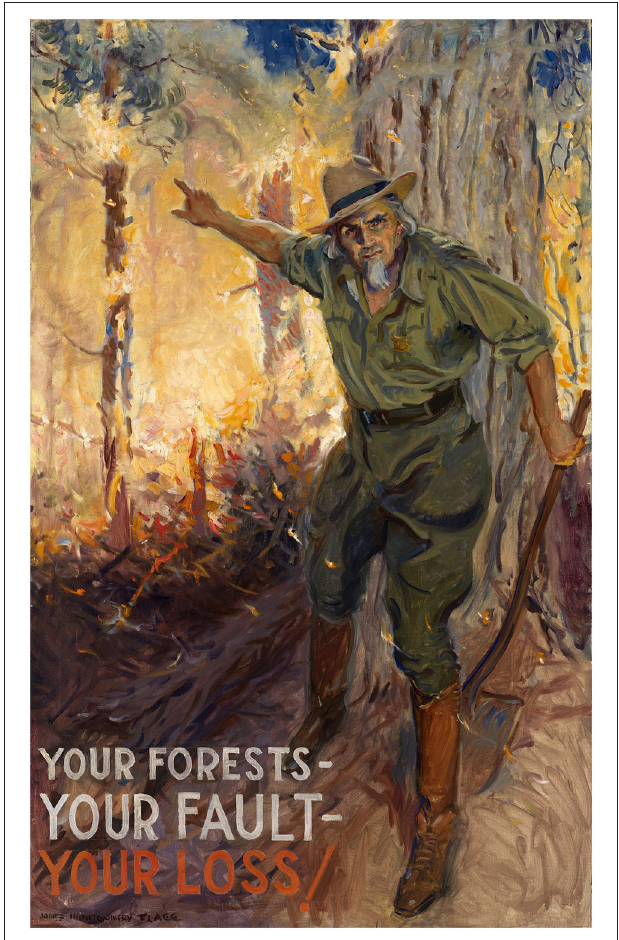
FIGURE 7 | Your forests—your fault—your loss (Flagg,